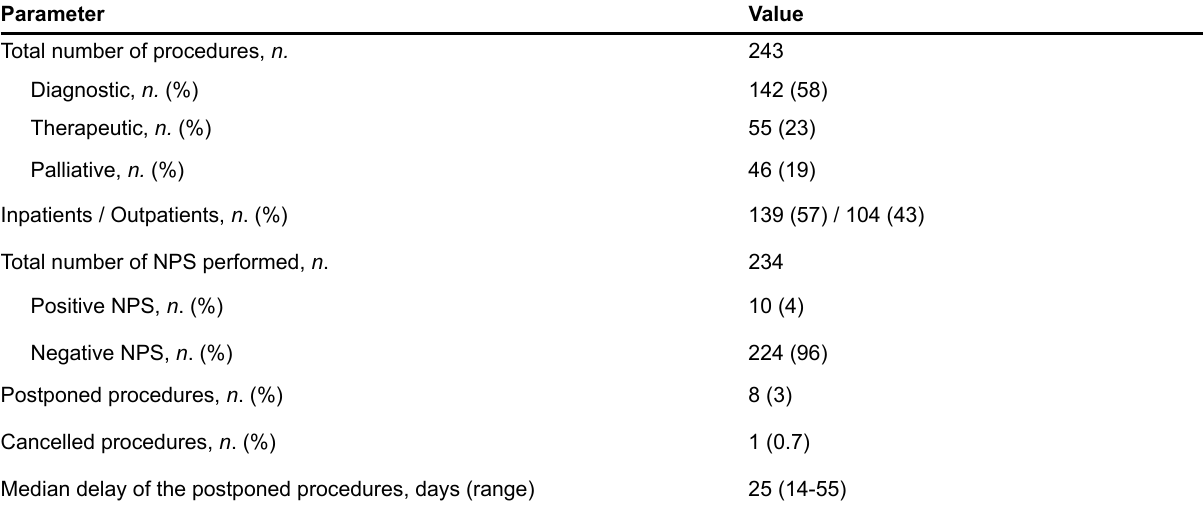
Table 2. Summary of scheduled procedures, swabs performed and main results Parameter